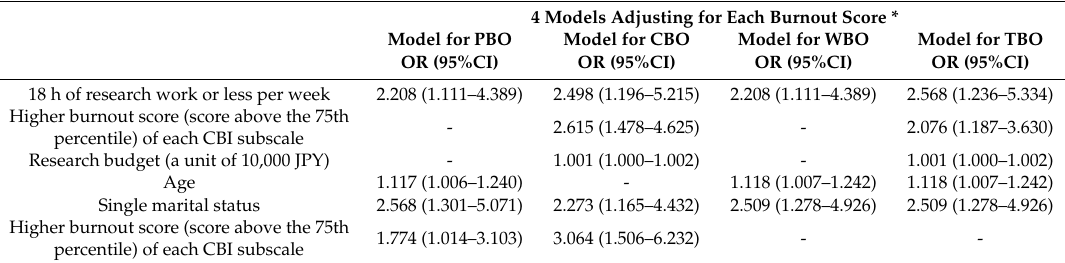
Table 4. Multivariablef stepwise logistic regression results for the two types of negotiation experiences according to 4 models adjusting for each burnout score; all models included each burnout scale, one at a time. 4 Models Adjusting for Each Burnout Score * Model for